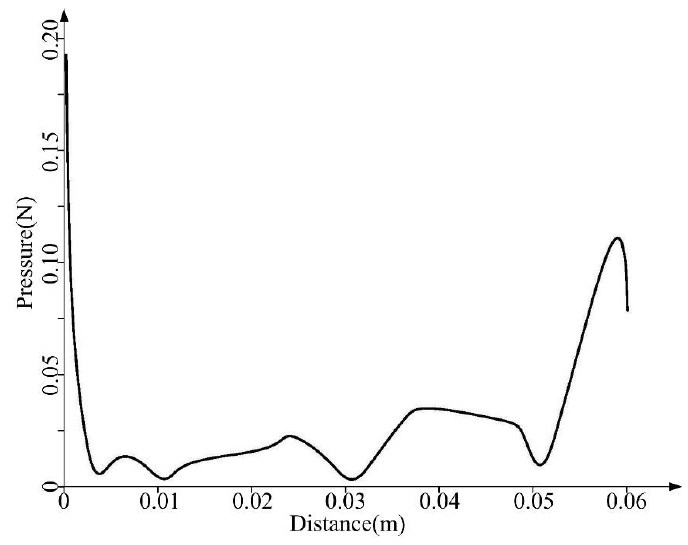
Figure 16. Forces of particles in the optimized flow passage.